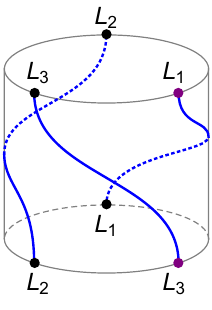
Figure 23 . The cyclic permutation map from V L points is such that the purple dot is the last one.